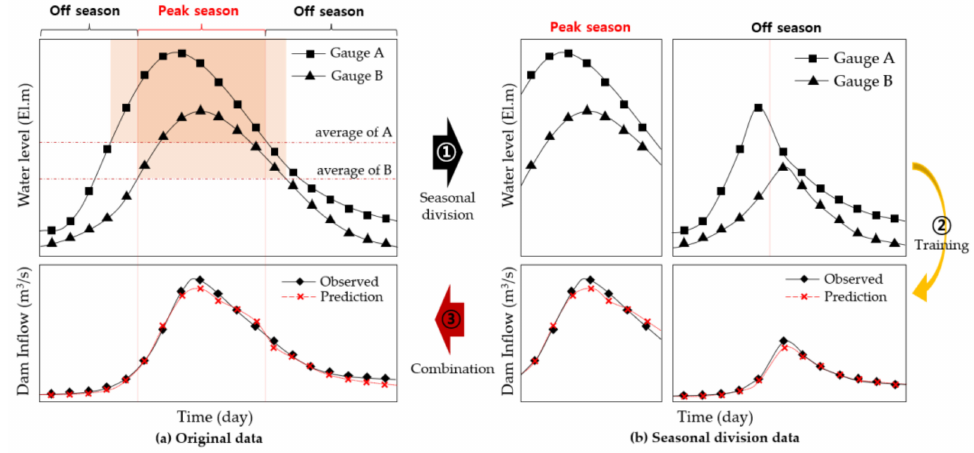
Figure 2. Seasonal division